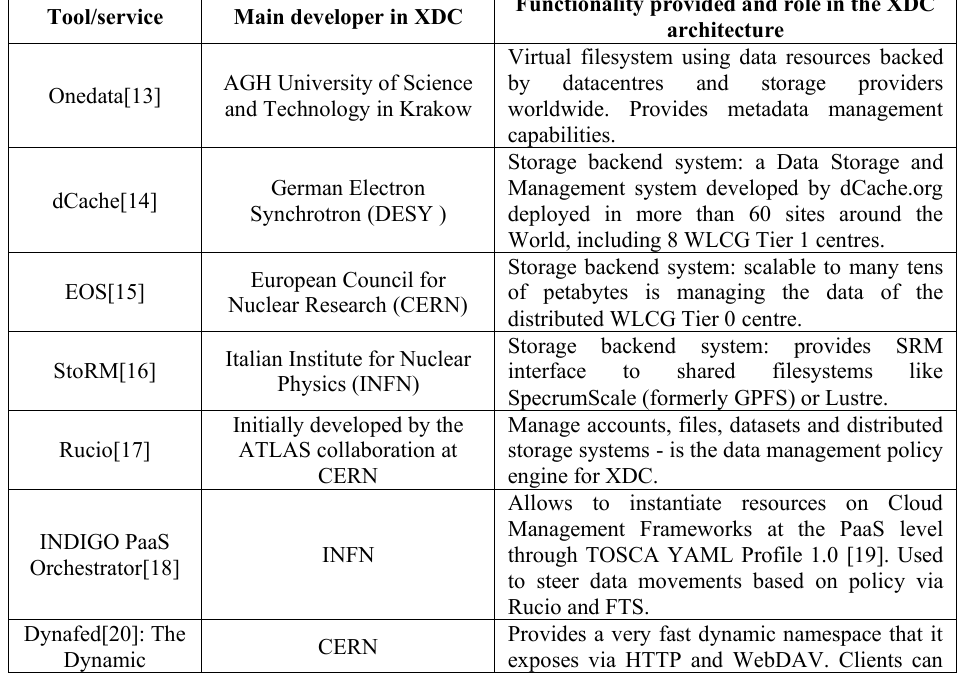
Table 2 – The XDC « toolbox » - the services developed by XDC partners and/or used to implement the XDC architecture for data management